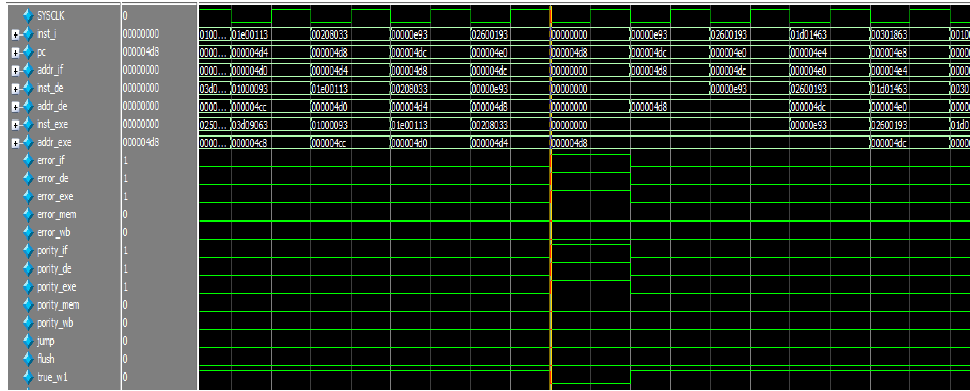
Figure 27. Exception handling in the case of multiple errors in a single cycle.